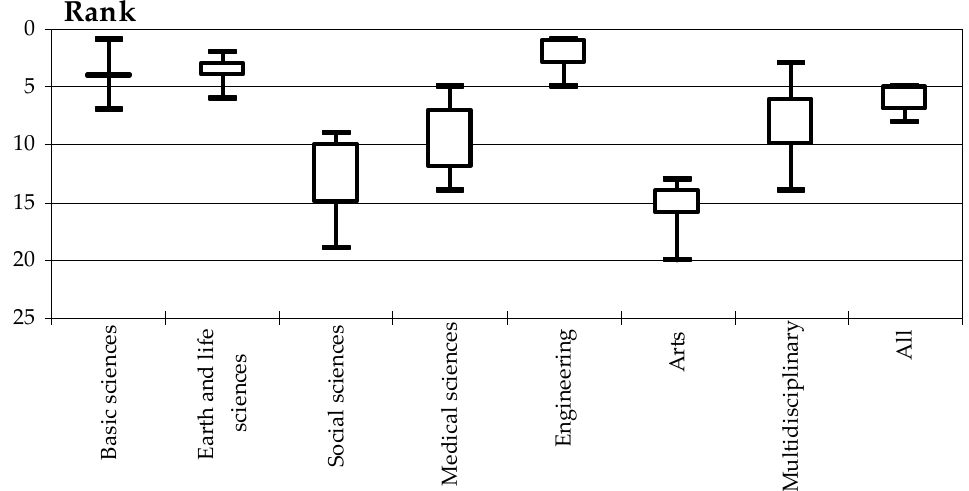
Figure 11. The visibility of articles published in aggregated research areas in Slovenia during 2010–2018, measured based on the adjusted number of citations per document. The figure displays boxplots based on the ranks of the aggregated research areas computed for each year separately. The results indicate variability across the research areas and a poorer performance in arts.